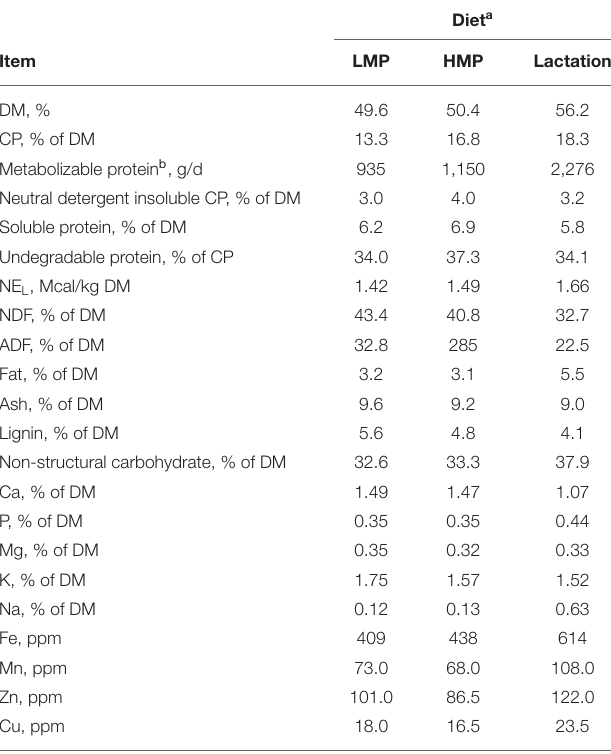
Table 4 lists data for the postpartum variables